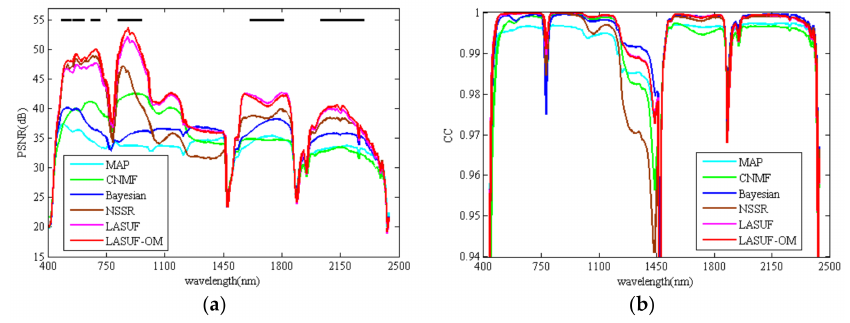
Figure 7. Comparisons of statistical indexes of individual bands for Salinas: ( a ) PSNR; ( b )